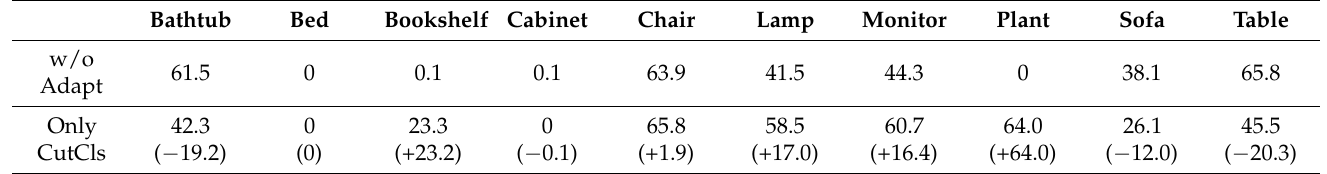
Table 3. Category-wise classification accuracy (%) on the S10 → S*10